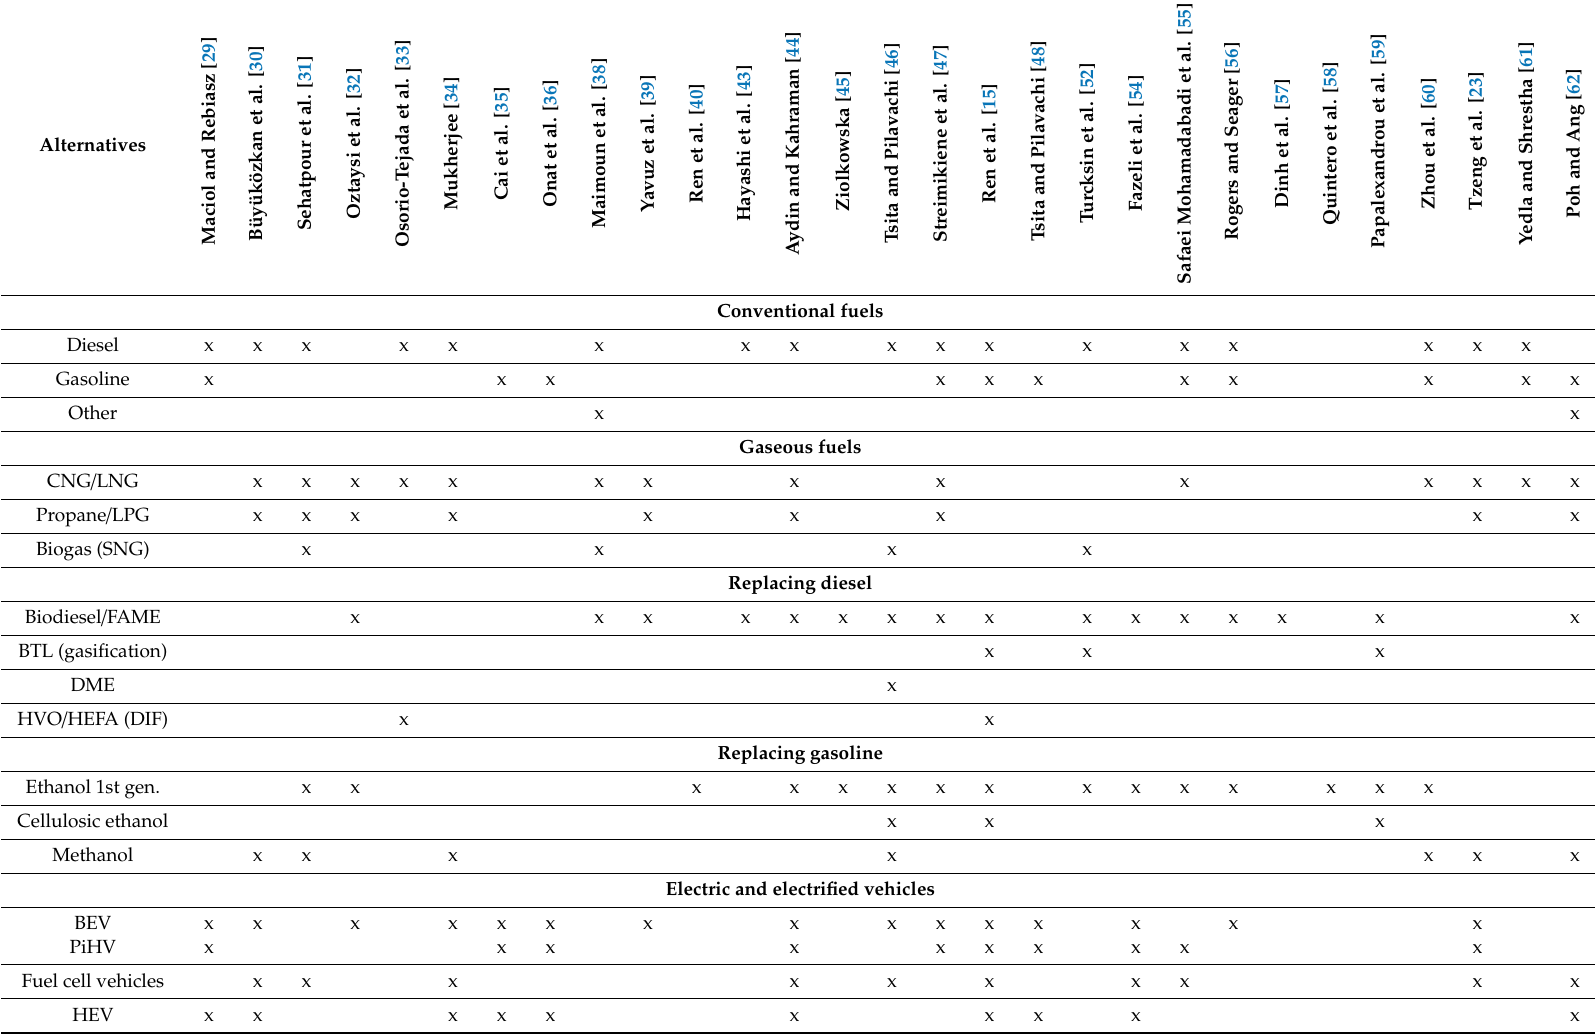
Table 6. Alternative fuels and vehicles as analysed in the reviewed